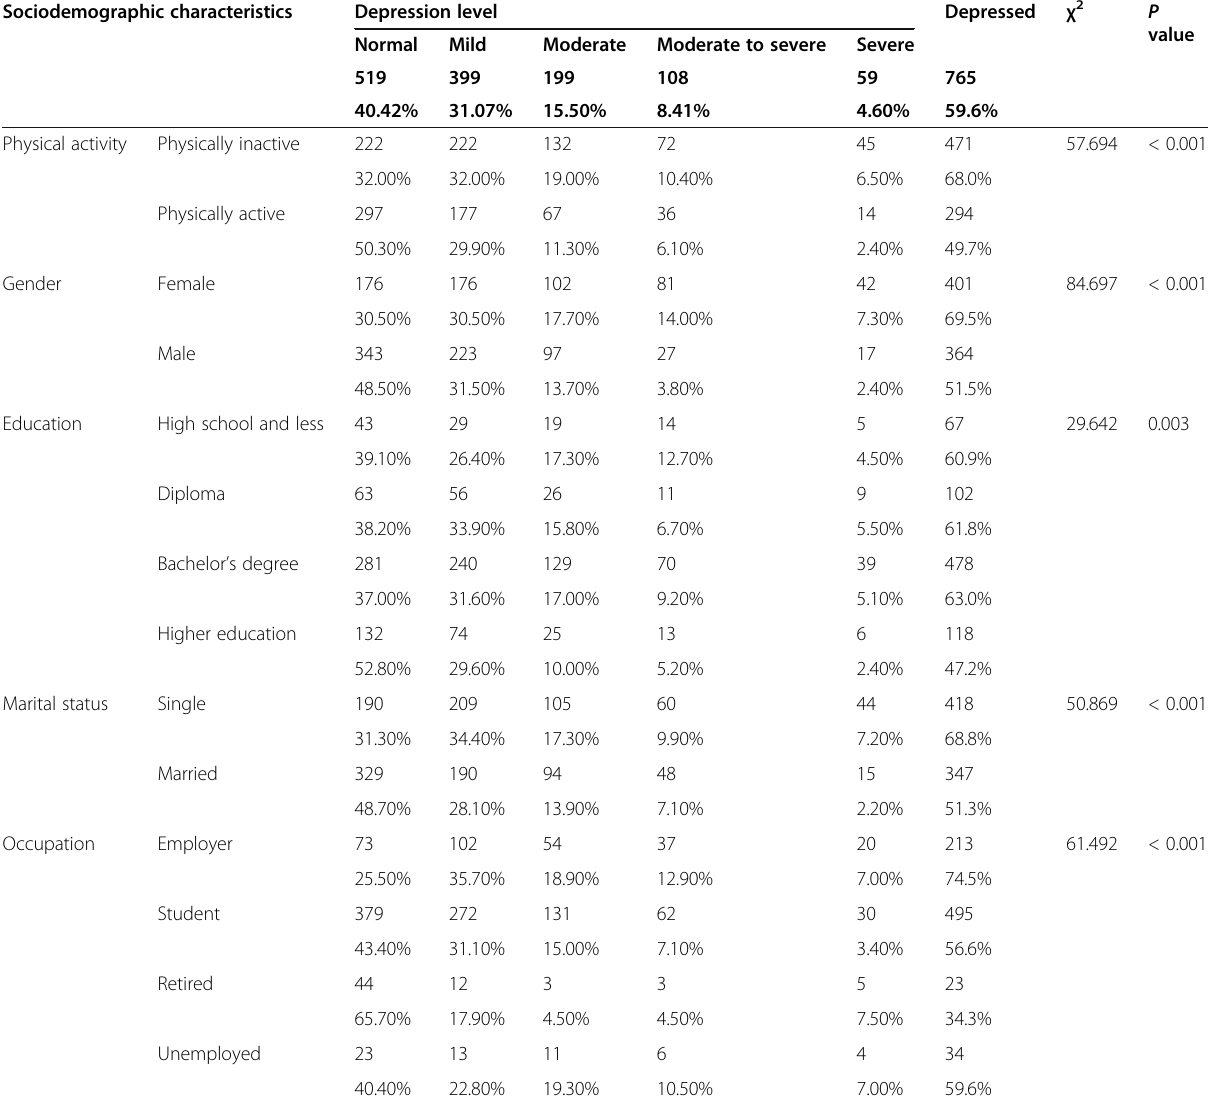
Table 3 Prevalence of depression (PHQ-9) among groups during the outbreak of COVID-19 in Kuwait Sociodemographic